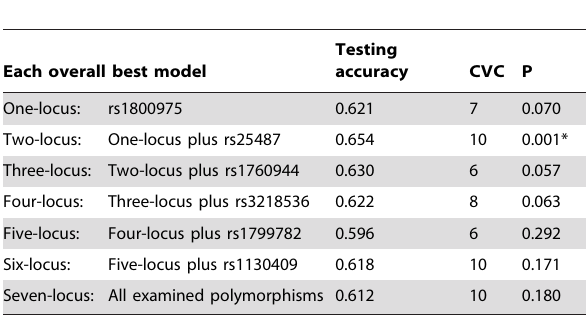
Table 4. Summary of multifactor dimensionality reduction (MDR)